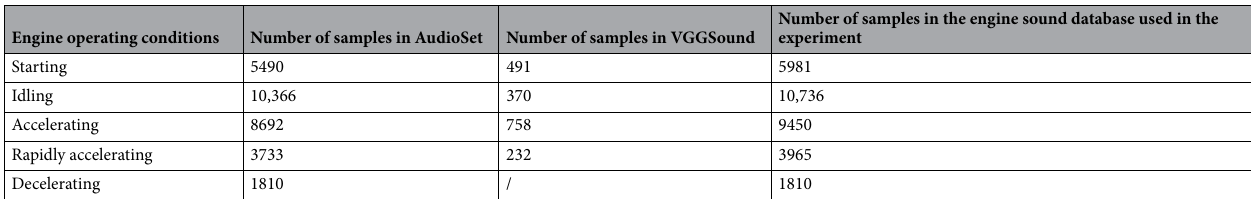
Table 1. Distribution of "engine" class data samples in AudioSet and VGGSound datasets.